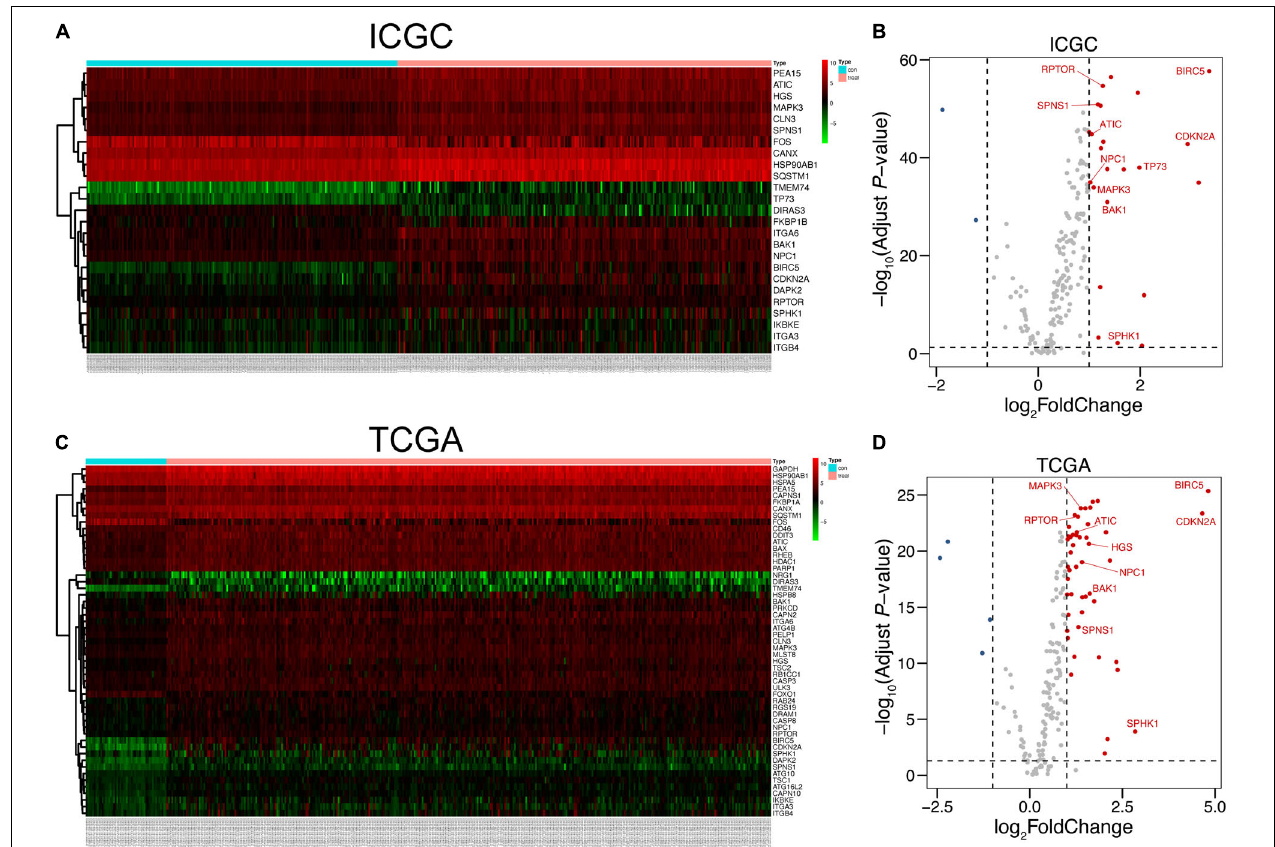
FIGURE 2 | Autophagy-related DEGs of HCC in ICGC and TCGA. (A,C) Heat maps of DEGs in ICGC and TCGA. The number of normal tissues was 202, and the number of tumor tissues was 243, all retrieved from ICGC. As for TCGA, the number of normal samples was 50 and that of tumor samples was 374. (B,D) Volcano plots of DEGs in the ICGC and TCGA databases. Ten hub genes studied in our research were labeled in the corresponding position. The detailed analytic information of the autophagy-related genes is presented in Supplementary Tables 1 , 2